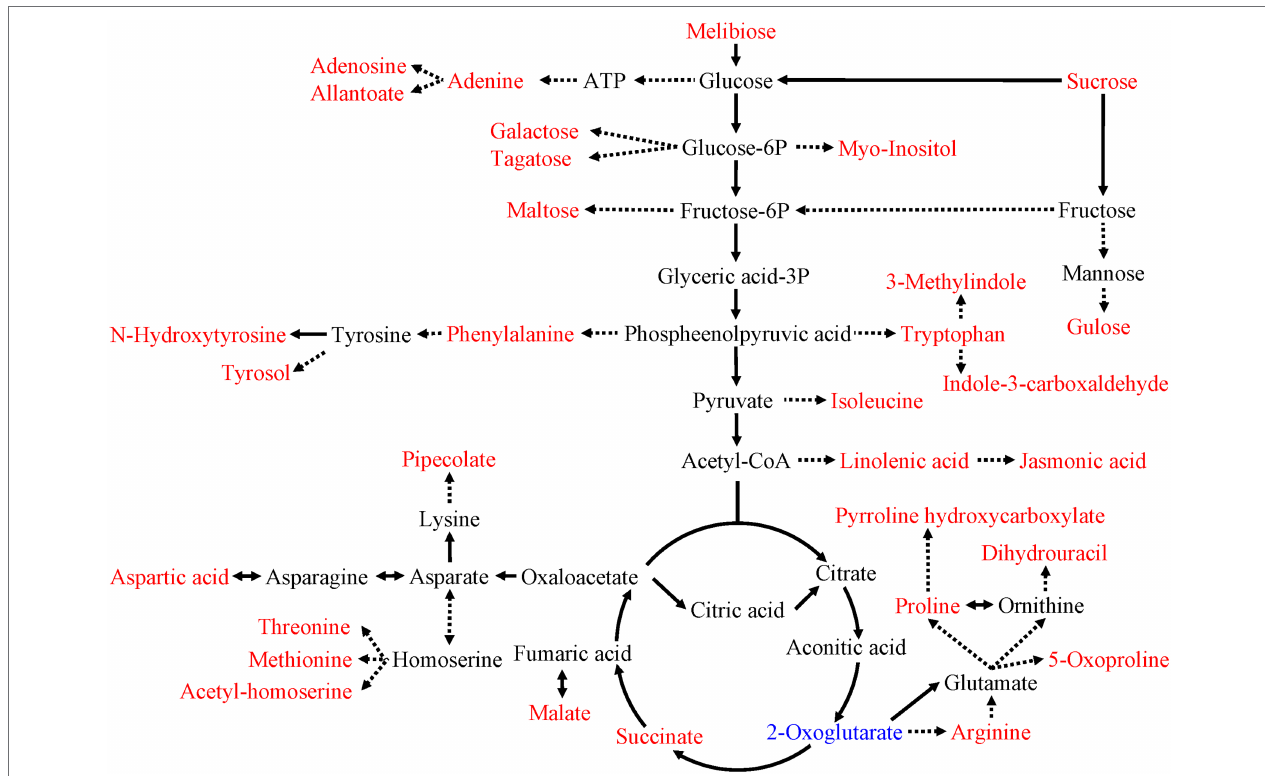
FIGURE 6 | Effects of drought stress on the central metabolic pathways of C. breviculmis . The metabolites in the red or blue text were the differential metabolites detected in the present work. The words in the red/blue represent up-regulation/down-regulation of metabolites under drought treatments, respectively. Arrows with full/dotted lines denote the direct/indirect reactions,